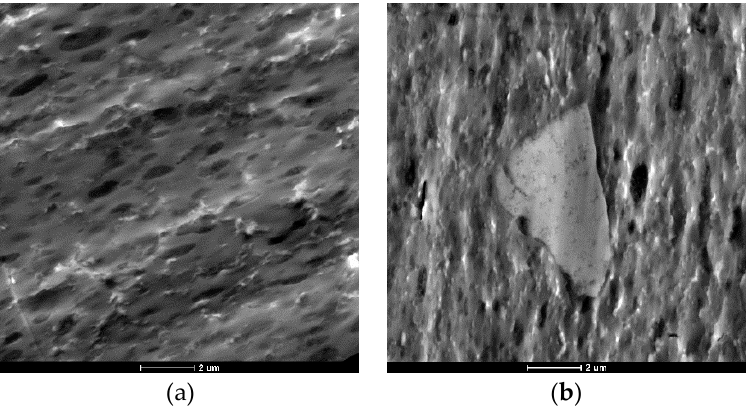
Figure 1. Transmission electron microscopy (TEM) micrographs of: ( a ) pure Xenoy XL1339; ( b ) post- industrial (POST-I) blend.